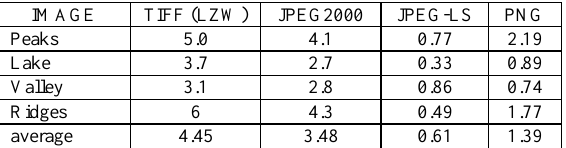
TABLE 2 - Lossless decoding times (secs.) for the PNG compression protocol as compared to TIFF (LZW), JPEG-2000 and